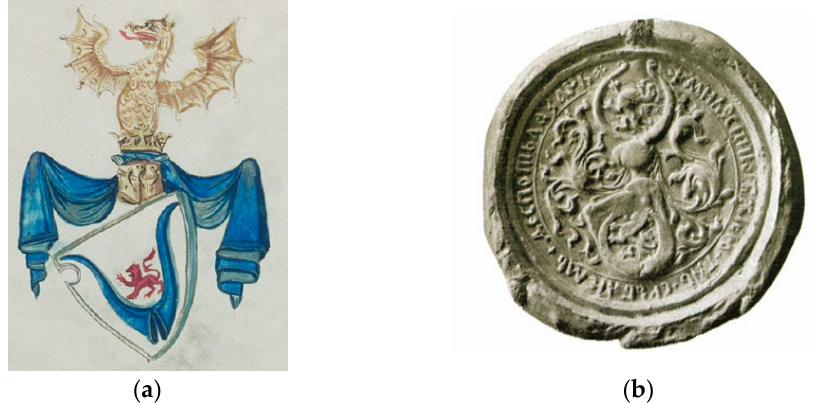
Figure 4. ( a ) Brankovici’s family coat of arms (London Armorial); ( b ) a seal of Vuk Brankovic.